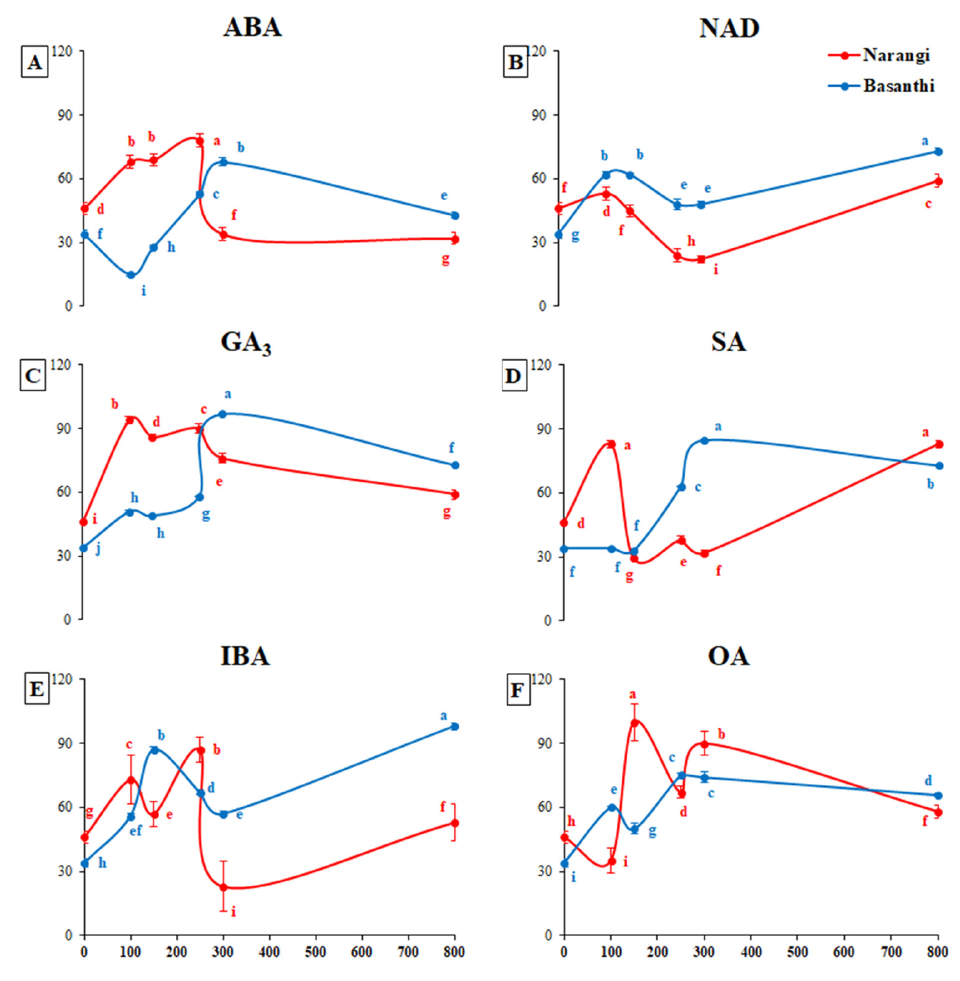
Figure 6. Total flavonoid contents (mg ∙ g − 1 ) of two cultivars of marigold (“Pusa Narangi Gainda” and “Pusa Basanthi Gainda”) as affected by different doses (mg ∙ L − 1 ) of ABA ( A ); NAD ( B ); GA 3 ( C ); and “Pusa Basanthi Gainda”) as affected by different doses (mg · L − 1 ) of ABA ( A ); NAD ( B ); GA 3 ( C ); SA ( D ); IBA ( E ) and OA ( F ). Same letters indicate non ‐ significant difference among treatments under SA ( D ); IBA ( E ) and OA ( F ). Same letters indicate non-significant difference among treatments under Fisher’s least significant difference test ( p ≤ 0.05 ). Vertical bars indicate average ± standard error Fisher’s least significant difference test ( p ≤ 0.05). Vertical bars indicate average ± standard error (three replications, under bi ‐ factorial CRD). (three replications, under bi-factorial